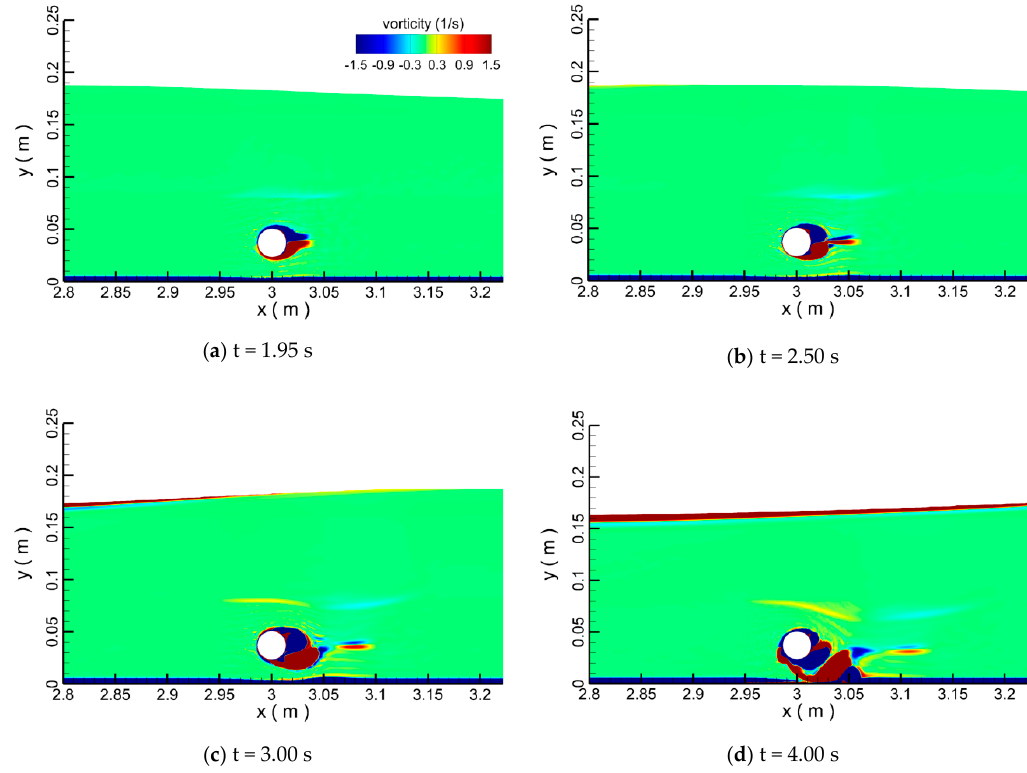
Figure 5. Same as Figure 3 but for run 2.